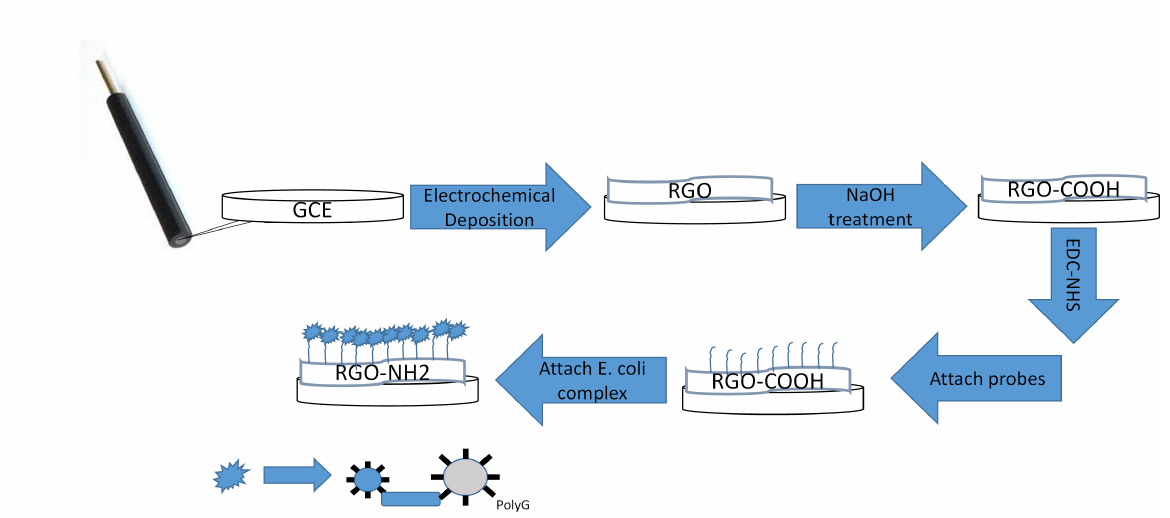
Figure 4. Schematic of GCE preparation for capture of the magnetic bead/ E. coli /secondary bead